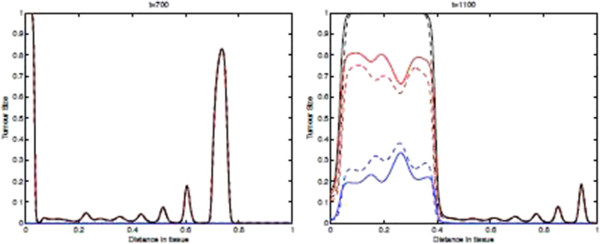
Tumour Spatial density in presence of immunoevasive mechanisms. Plots showing the distribution of tumour cell density within the tissue at times corresponding to 700, and 1100 days respectively. These plots illustrate the spatiotemporal onset of immunoevasion. The final plot at t=1100 should be compared to the equivalent plot in Figure 9, whereas the plot in the left panel, referring to time t=700 days, is analogous to the equivalent plot in Figure 9. These plots suggests that the onset of immunoevasion occurs after t=700days. Parameter values pN=0.75 and ki+=constant. Solid line with chemorepellent, dashed line without. The red lines represent the population T0, The blue lines represent the summed population T1 + … + TN, and the black lines represent the summed population T0 + … + TN.